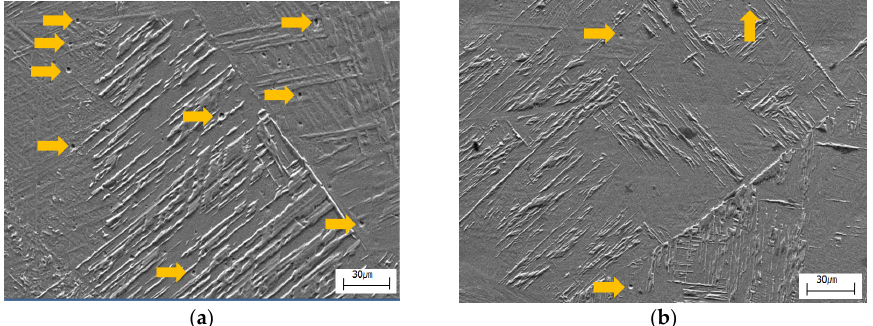
Figure 6. SEM image of pores in weld metal: Yellow arrows indicate pores: ( a ) WO; ( b ) R03.